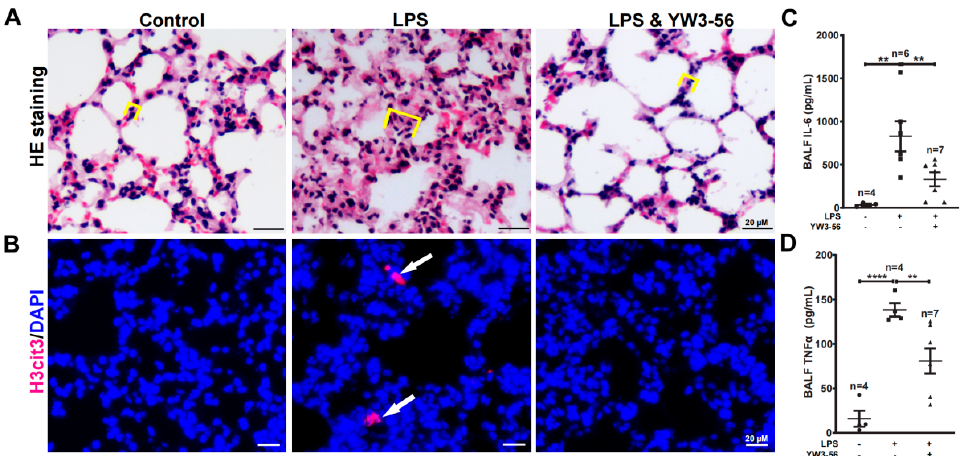
Figure 4. YW3-56 treatment decreased histone citrullination in lung sections, alveolar wall thickening, as well as IL-6 and TNF α levels in bronchoalveolar lavage fluid (BALF). ( A ) After LPS treatment, alveolar wall was much thickened analyzed with H&E staining. YW3-56 treatment largely reversed alveolar wall (yellow box line marked) thickening. ( B ) After LPS treatment, histone citrullination (red) was increased in lung sections detected by immunostaining with a histone H3Cit (Cit2, 8, 17) antibody and DNA dye DAPI staining (blue). Histone citrullination was decreased upon YW3-56 treatment. ( C , D ) BALF IL-6 ( n = 4, 6, 7) and TNF α ( n = 4, 4, 7) levels were much increased after LPS treatment, while YW3-56 treatment significantly decreased IL-6 and TNF α levels. Scale bars represent 20 μ m. All data in figures were presented as mean ± SEM. ** p < 0.01; **** p < 0.0001. IL, interleukin; TNF, tumor necrosis factor; NET, neutrophil extracellular trap; cfDNA, cell free DNA; LPS, lipopolysaccharides; BALF, bronchoalveolar lavage fluid.